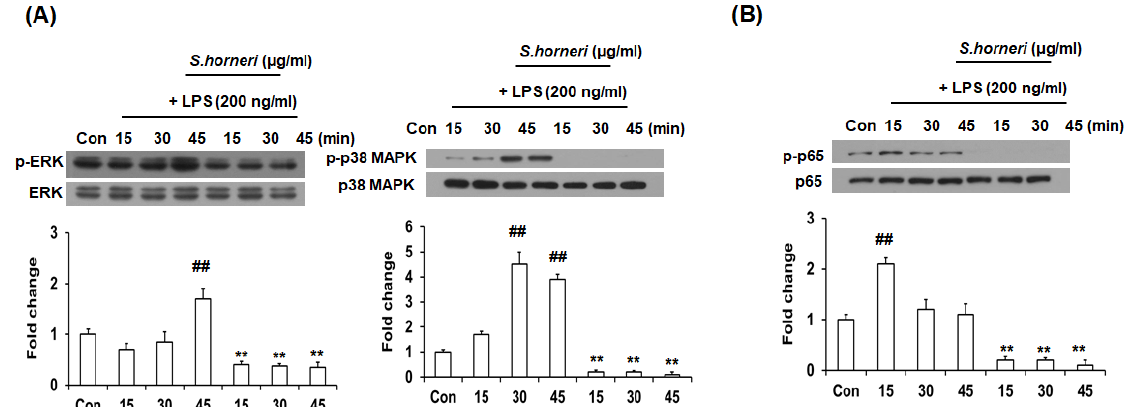
Figure 4. S. horneri attenuated LPS-induced MAPK phosphorylation and NF-κB translocation. Cells were pre-treated with 300 µg/mL of S. honeri for 2 h, followed by treatment of LPS (200 ng/mL) for 15, 30 and 45 min. The expression of phosphorylated proteins was measured by Western blot. The total extracts and nucleus extracts were assayed with antibodies specific for p-ERK, p-38 MAPK and p-p65 (NF-κB). Total form and β-actin were used as internal control for total fraction. The blots are representative of three independent experiments ( A , B ). Each bar indicates the mean ± SE of four independent experiments. ** p < 0.001, significantly different from LPS-treated group; ## p < 0.001, significantly different from LPS-untreated group.